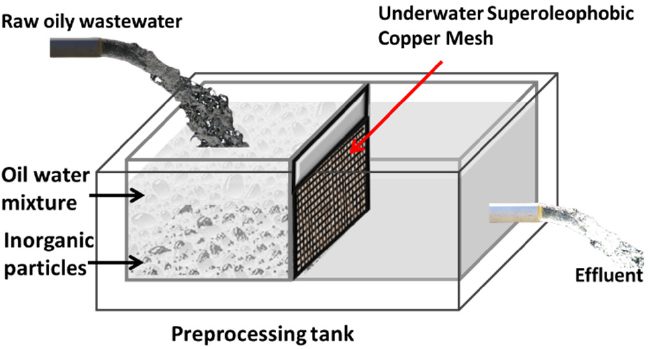
Figure 1. The schematic illustration of the application of copper mesh in a preprocessing tank of raw oily wastewater.